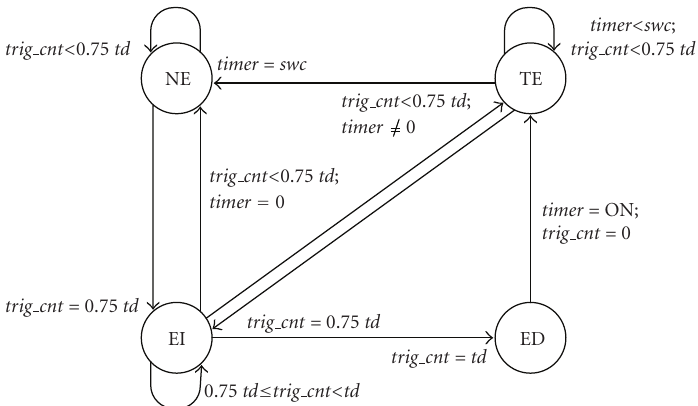
Figure 18: Plateau detector states and